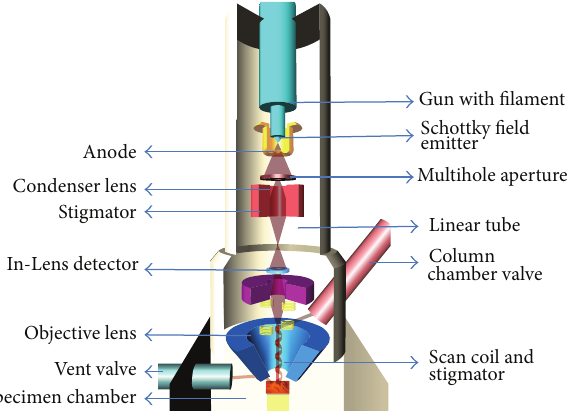
Figure 3: Principle of FE-SEM